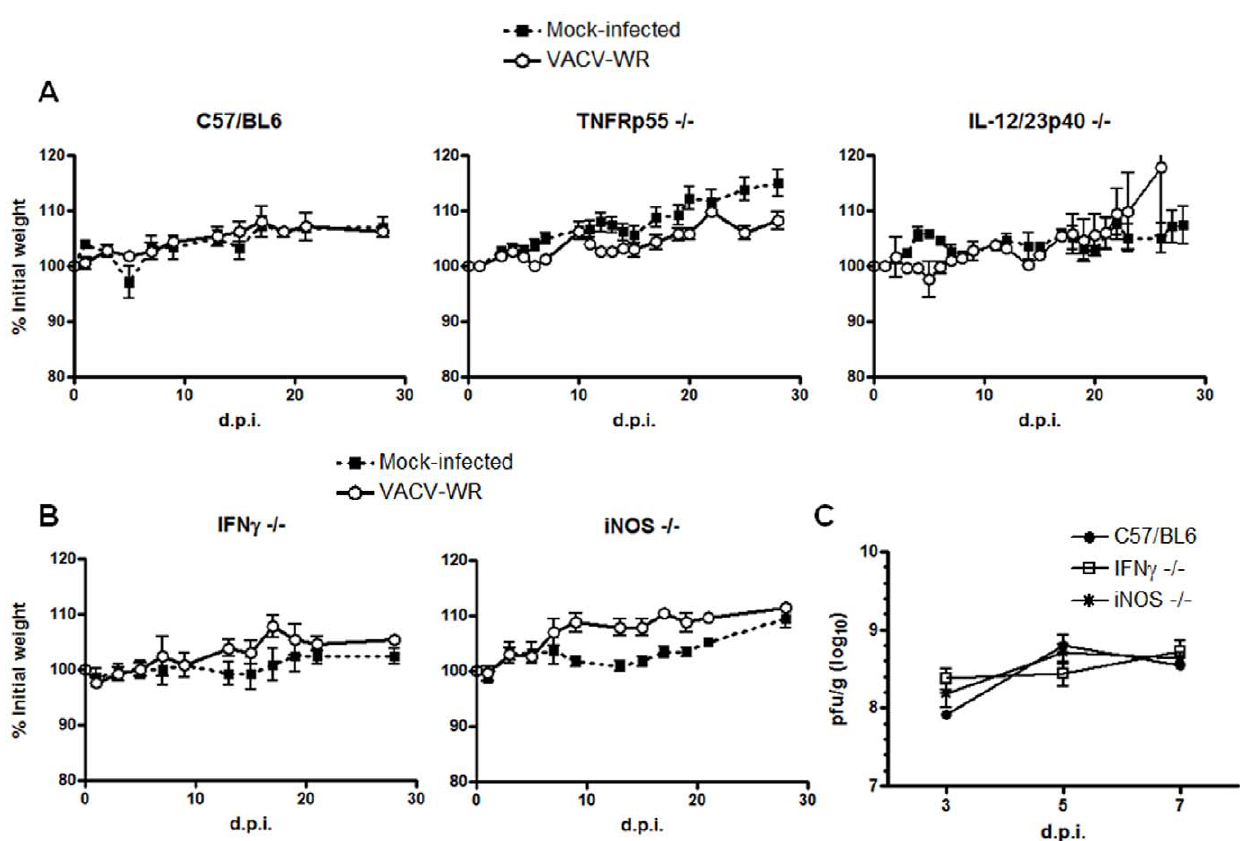
Figure 1. VACV infection in single-cytokine deficient mice did not alter the outcome of infection. C57BL/6 ( n =6), IL-12/23 2 / 2 ( n =4), TNFR 2 / 2 mice ( n =7), IFN c 2 / 2 ( n =6) and iNOS 2 / 2 ( n =6) animals were infected with 10 7 p.f.u. of VACV-WR by tail scarification. ( A ) Weight curve of C57BL/6, IL-12/23 2 / 2 , TNFR 2 / 2 mice. ( B ) Weight curve of IFN c 2 / 2 and iNOS 2 / 2 mice. ( C ) WT, IFN c 2 / 2 and iNOS 2 / 2 animals were euthanized at days 3, 5 and 7 post-infection (p.i.) and viral titers in tails were assessed by titration in BSC-40 cells. Bars represent the mean and standard error (SEM). The results shown are representative of two separate